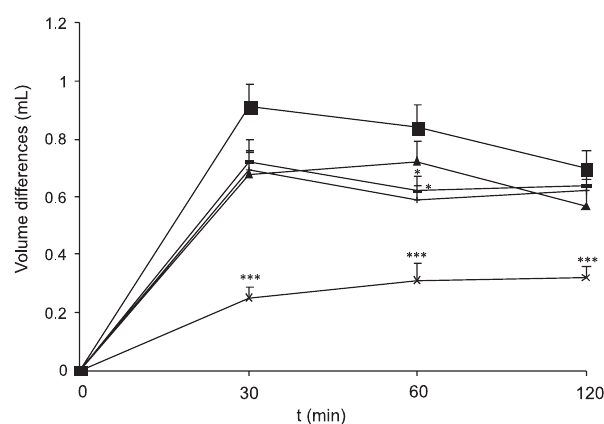
FIGURE 2 - Effect of oral treatment with vehicle (■), hydroethanolic extract of M. velame (HE Mv ) at doses of 50 (▲), 200 ( - ) and 800 ( + ) mg/kg, or 5 mg/kg of cyproheptadine ( × ), on dextran-induced paw edema in rats. Each value is the mean ± S.E.M. of 7-8 rats. *p<0.05 and ***p<0.001 compared with control. One-way ANOVA followed by Student-